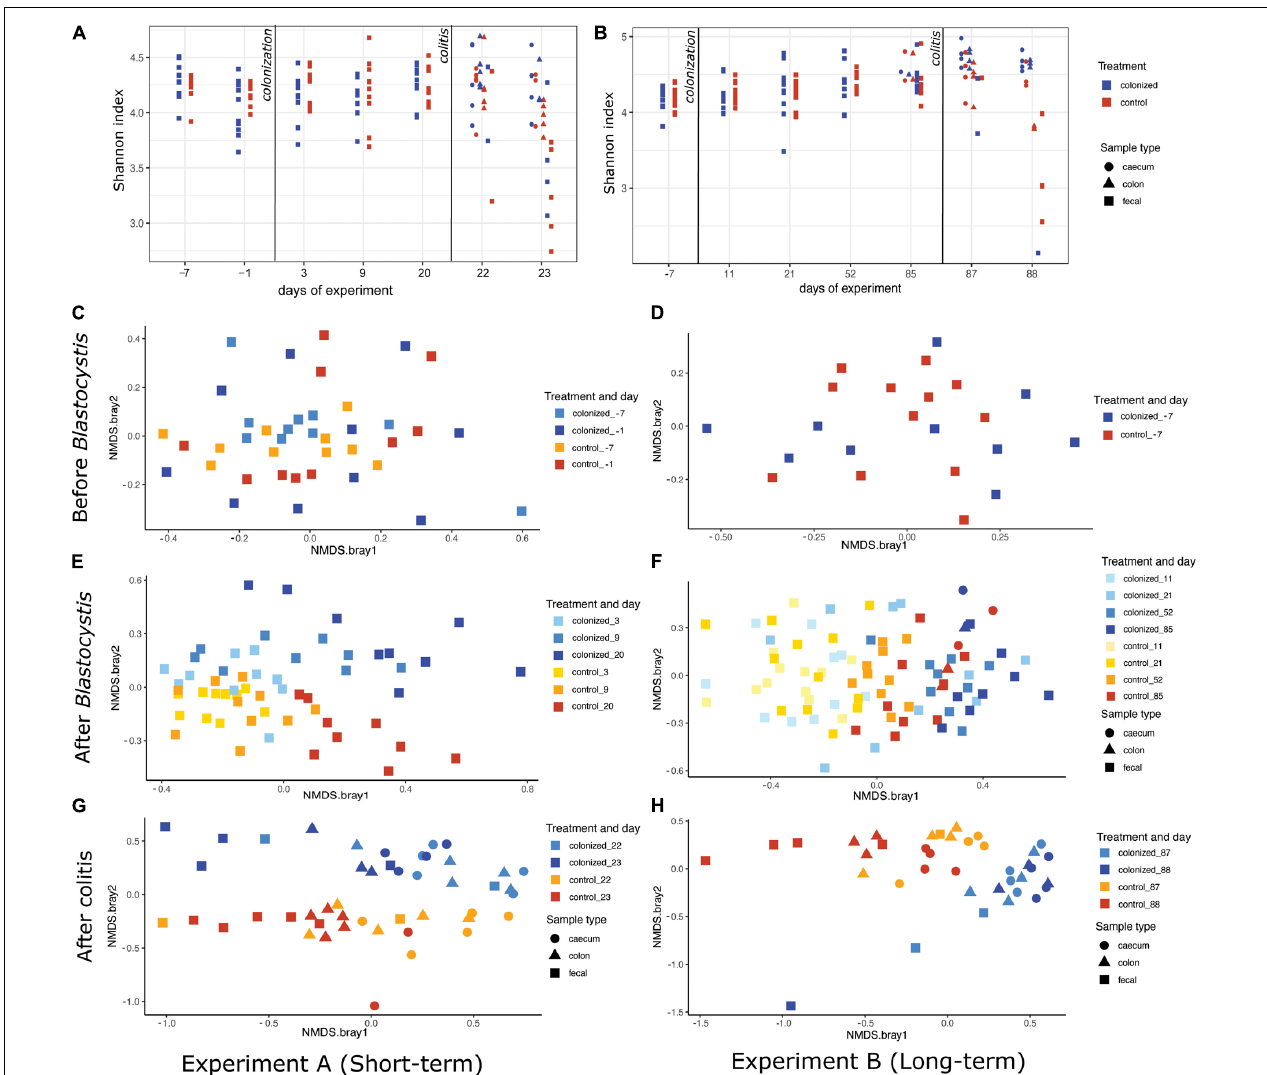
FIGURE 7 | Effect of Blastocystis ST3 colonization on rat gut bacterial diversity before and after colitis. Blastocystis ST3-colonized group is in blue, control group (i.e., non-colonized rats) in orange. (A,B) Alpha-diversity over time measured with the Shannon index. (A) Short-term colonization (3 weeks). (B) Long-term colonization (13 weeks). Sample types are represented by shapes with cecum (circle), colon (triangle), and fecal (square). The first vertical line indicates Blastocystis ST3 inoculation and the second vertical line indicates the induction of colitis using DNBS. (C–H) NMDS plots of Bray-Curtis dissimilarity visualize the difference in gut microbiota composition between the control group (warm shades) and rats colonized by Blastocystis ST3 (cool shades). Prior to Blastocystis ST3 inoculation, fecal samples: (C) short-term colonization and (D) long-term colonization. After Blastocystis ST3 colonization: (E) short-term colonization and (F) long-term colonization. After colitis induction: (G) short-term colonization and (H) long-term colonization. Differences between groups are calculated with a PERMANOVA followed by Benjamini-Hochberg correction on single days and single samples type. Results of statistical tests are presented in Table 2